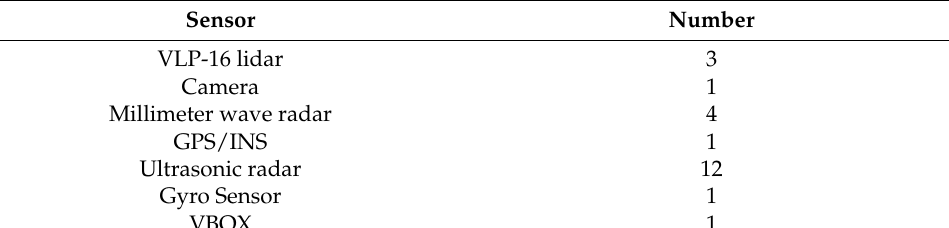
Table 1. Configuration of sensors.